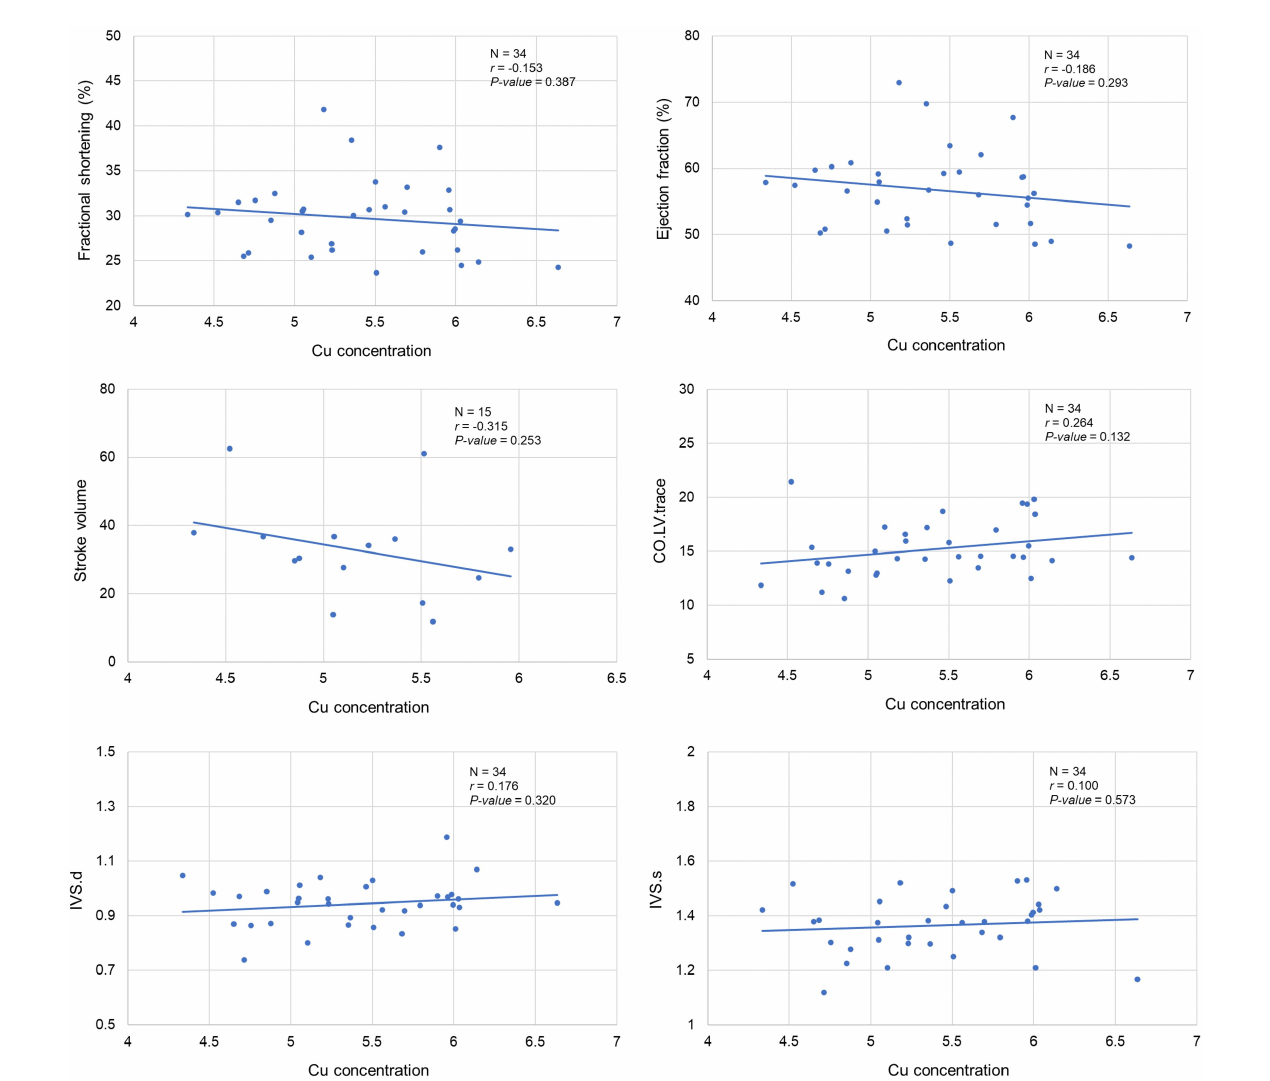
FIGURE4 Correlation between cardiac copper (Cu) concentration and echo phenotypes (FS%, EF%, stroke volume, CO, and IVS). The x-axis indicates the Cu concentration ( µ g/g), and y axis denotes the echocardiography parameters. The Pearson correlation coefficient was used to determine the relationship between cardiac Cu concentration and echo phenotypes. The Pearson correlation r and P -values are indicated in the plots. LV, left ventricular; s, end-systole; d, end-diastole; CO, cardiac output; IVS, interventricular septum.